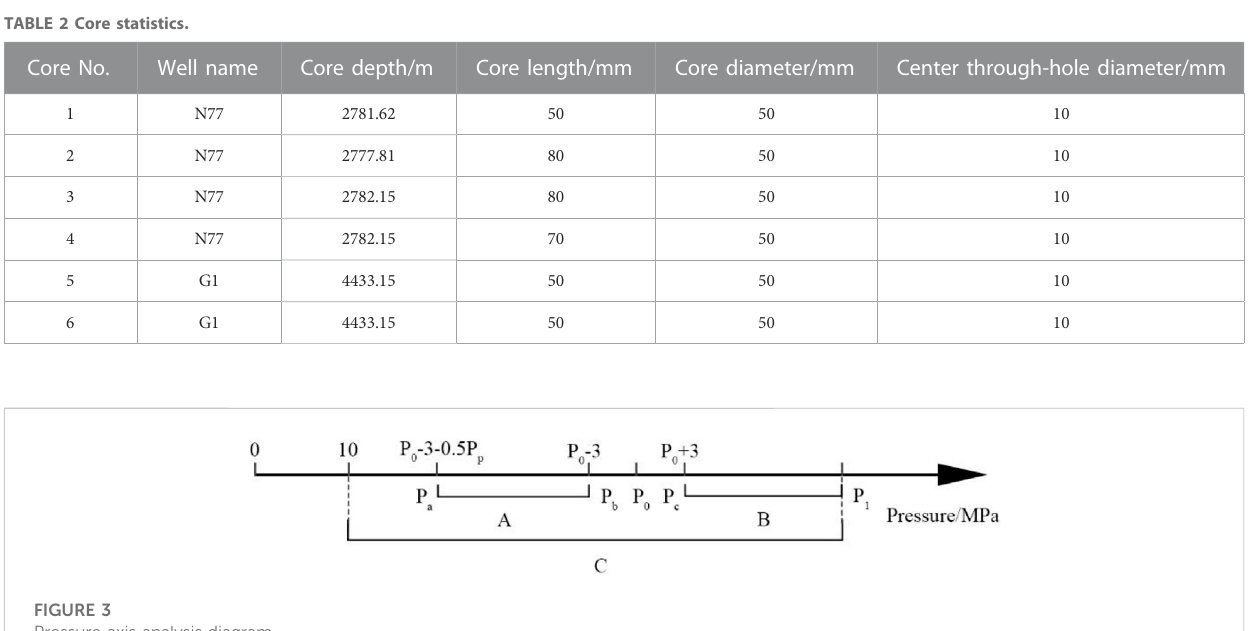
FIGURE 3 Pressure axis analysis diagram.